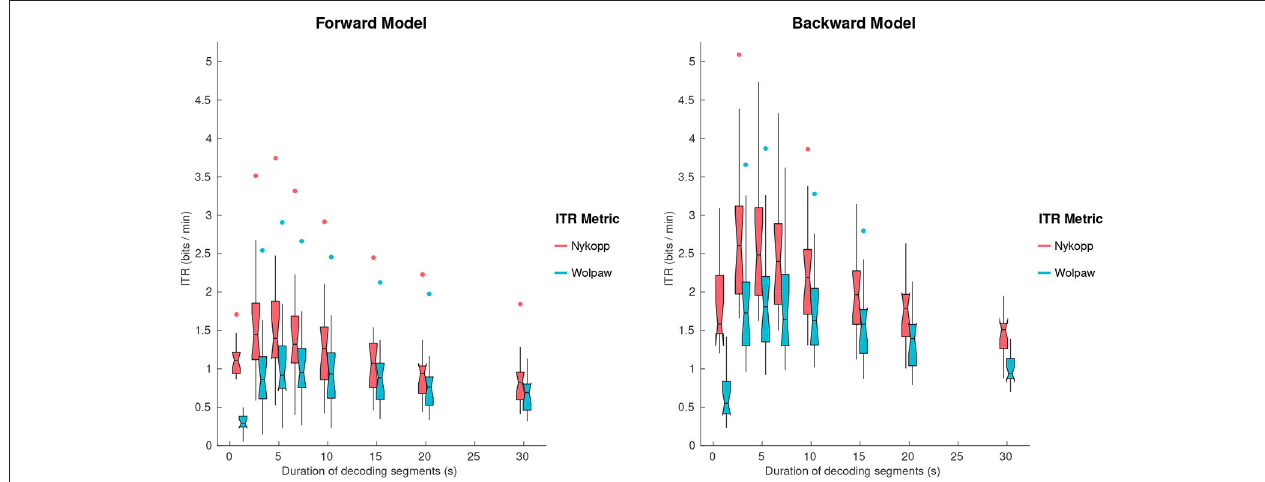
FIGURE 6 | Wolpaw and Nykopp information transfer rates (ITR) as a function of decoding segment duration for the forward and backward models, using Tikhonov regularization. Notched boxplots show median, and first and third quartiles. Whiskers show 1.5 × IQR. Dots indicate